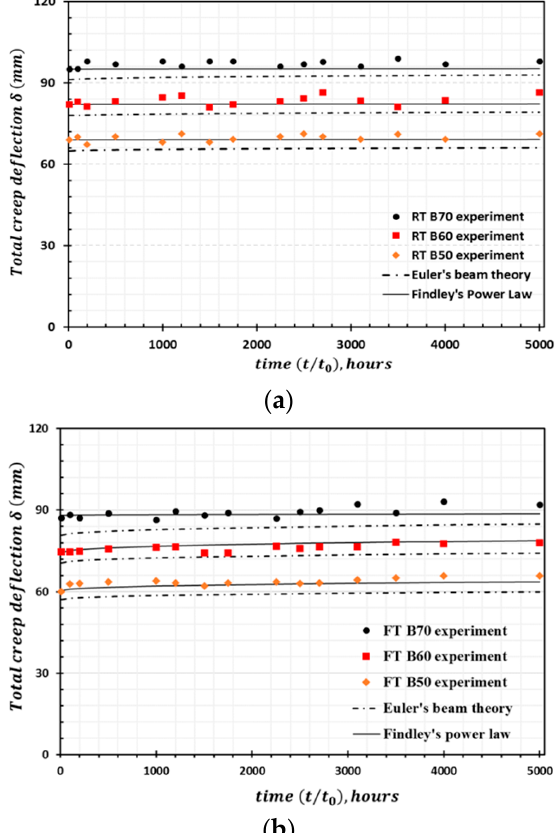
Figure 12. Deflection creep curve ( a ) RT samples and ( b ) FT samples; the plot compares creep deflection derived from the experiment, Findley’s power law model, and Euler Bernoulli’s beam theory